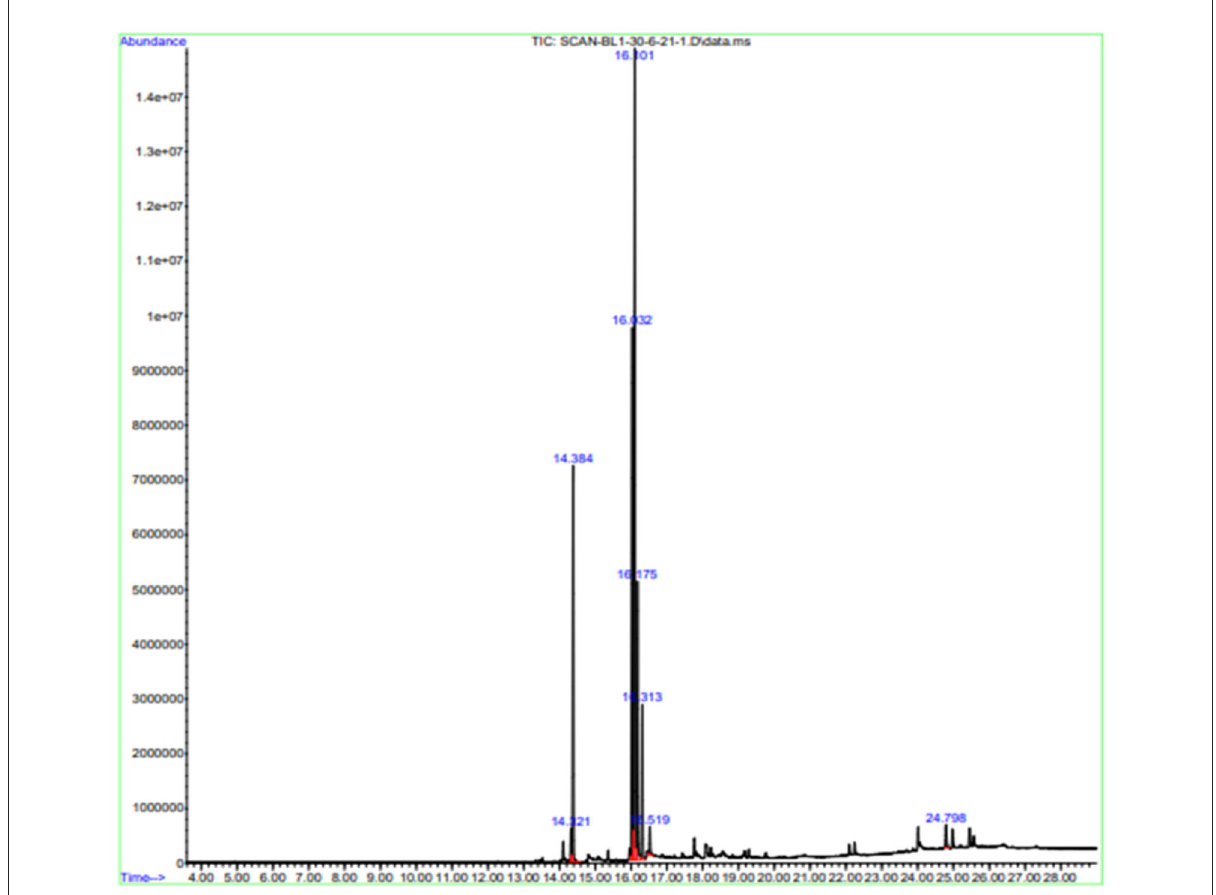
FIGURE12 Chromatogram of leaf extracts of B. aurea analyzed by the developed GCMS method.